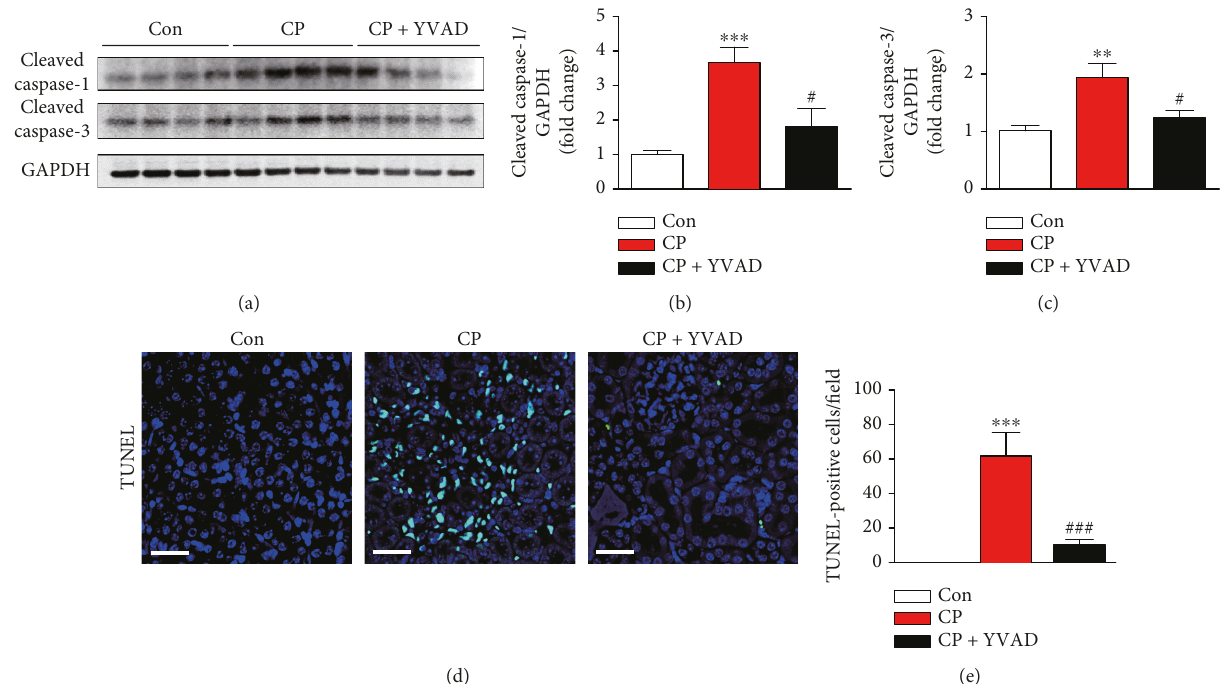
Figure 2: E ff ects of Ac-YVAD-cmk on cisplatin-induced apoptotic cell death in the kidneys. (a) Western blot analysis of the expression of cleaved caspase-1 and cleaved caspase-3 in the kidneys. Graphs show the results of quantitative analysis of cleaved caspase-1 (b) and cleaved caspase-3 (c). (d) Representative images of TUNEL staining on kidney sections. Nuclei were counterstained with DAPI. Scale bar: 50 μ m. (e) The number of TUNEL-positive cells in 5 random fi elds for each kidney. (f) Representative immuno fl uorescence staining of Ki67 (green) and p-H3 (red) on kidney sections. Nuclei were counterstained with DAPI. Scale bar: 50 μ m. (g) Percentage of cells in the G2/M phase among all proliferative (Ki67-positive) tubular epithelial cells. Con: control, CP: cisplatin, and CP +YVAD: cisplatin plus Ac-YVAD-cmk. n = 8 per group. All data are expressed as the mean ± SEM. ∗∗ P < 0 01 and ∗∗∗ P < 0 001 vs. Con. # P < 0 05 and ### P < 0 001 vs.